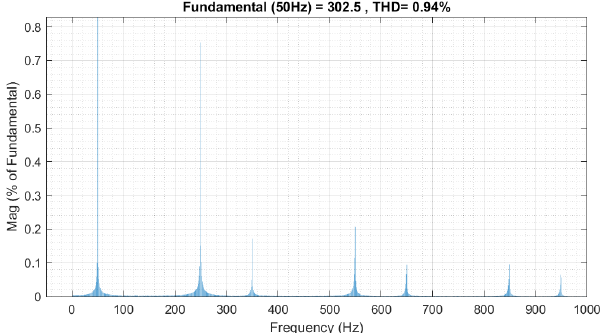
Figure 10. Transformer primary voltage total harmonic distortion .